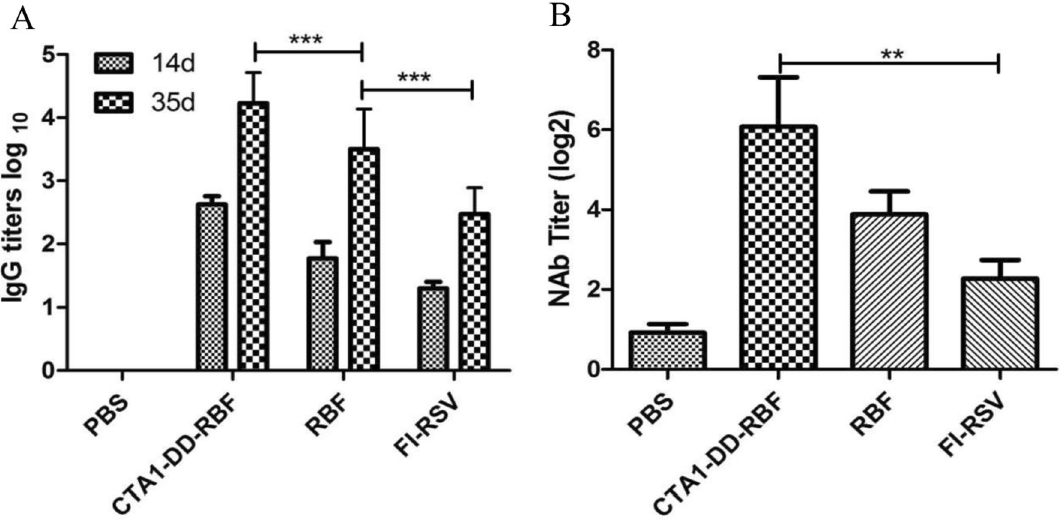
Figure 2. IgG and neutralizing antibodies induced by intranasal vaccination in mice. ( A ) Specific humoral immunity on day 14 (14 days after the initial immunization) and day 35 (14 days after the immunization boost). ( B ) The serum neutralizing titers against hRSV A Long were measured at day 35. The titers are presented as the dilution factors resulting in a 50% reduction in plaque numbers. Statistically significant differences were appropriately determined by one-way ANOVA, ***p < 0.001. The lines represent the median and interquartile range, and the bars represent the mean values with standard deviations.